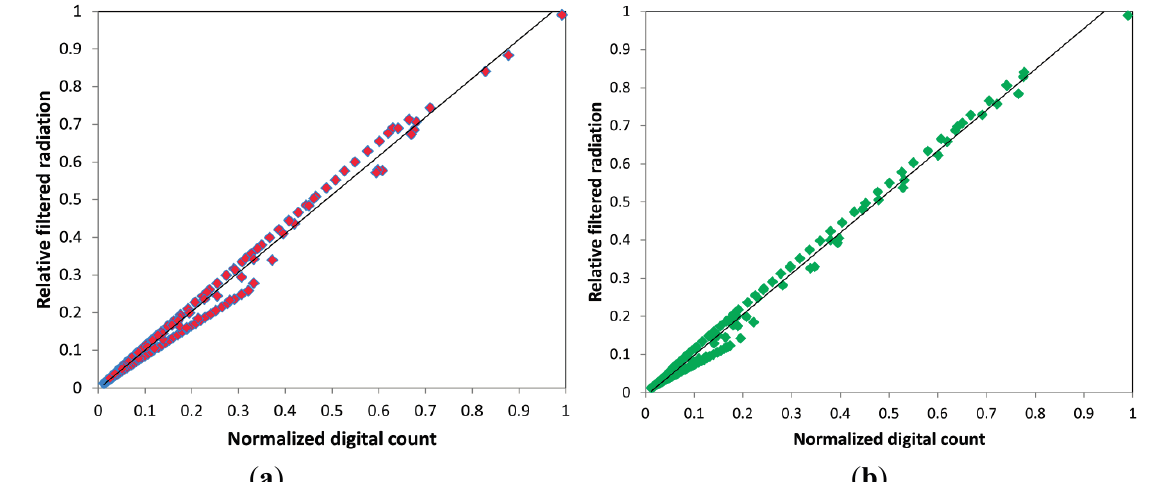
Figure 5. Normalized digital count VS. Relative filtered radiation received for the four channels ( a ) Red; ( b ) Green; ( c ) Blue; ( d )